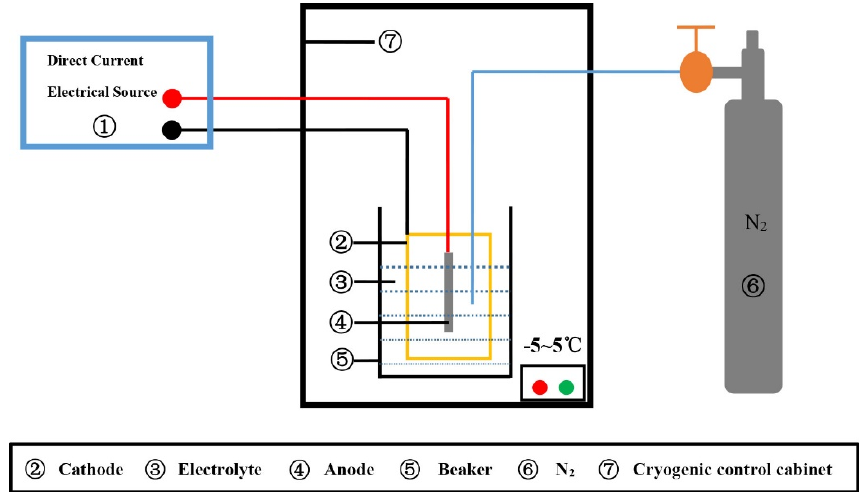
Figure 2. Electrolytic extraction device.